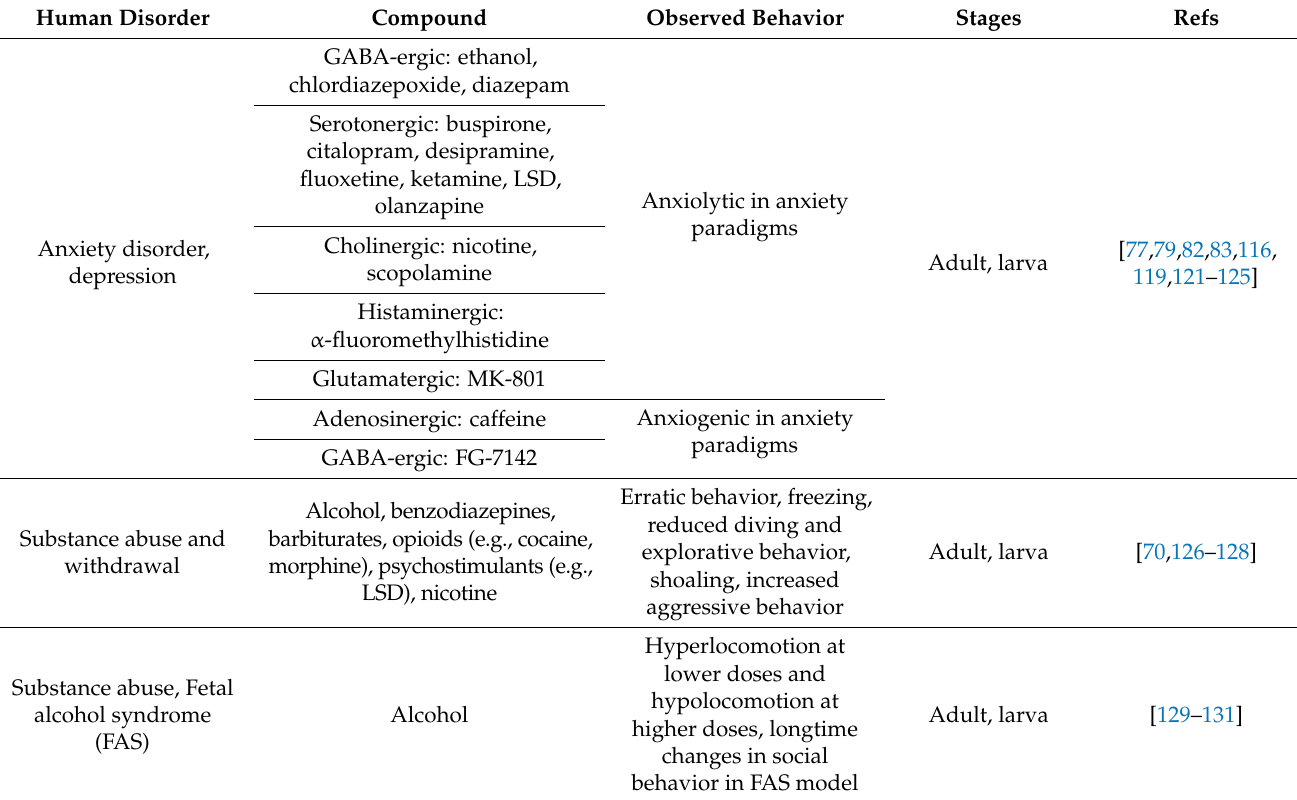
Table 2. Pharmacological approaches to study habenula linked